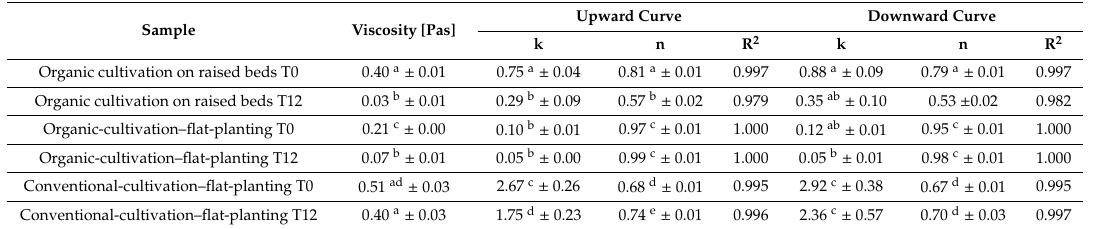
Table 5. Parameters of the Ostwald–de Waele model describing the rheological properties of 1% pectin solutions.